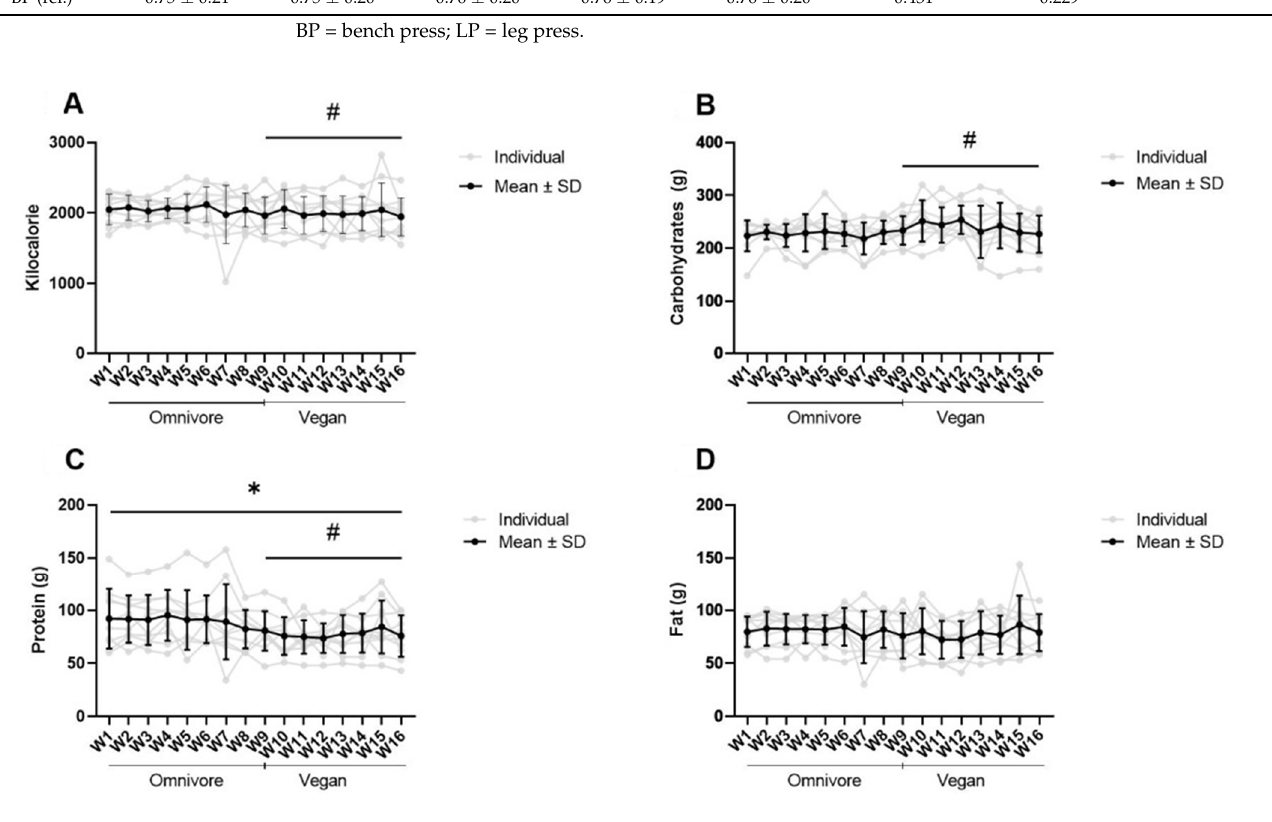
Figure 2. Change in self-documented calorie count ( A ) and macronutrients carbohydrates ( B ), pro- teins ( C ), and fats ( D ). All figures show the individual, self-documented intakes of the macronutrients or the calorie count in grey and the mean value in black. Significant differences were set p < 0.05 and market with # (group) and * (time). Table 3. relative protein intake.